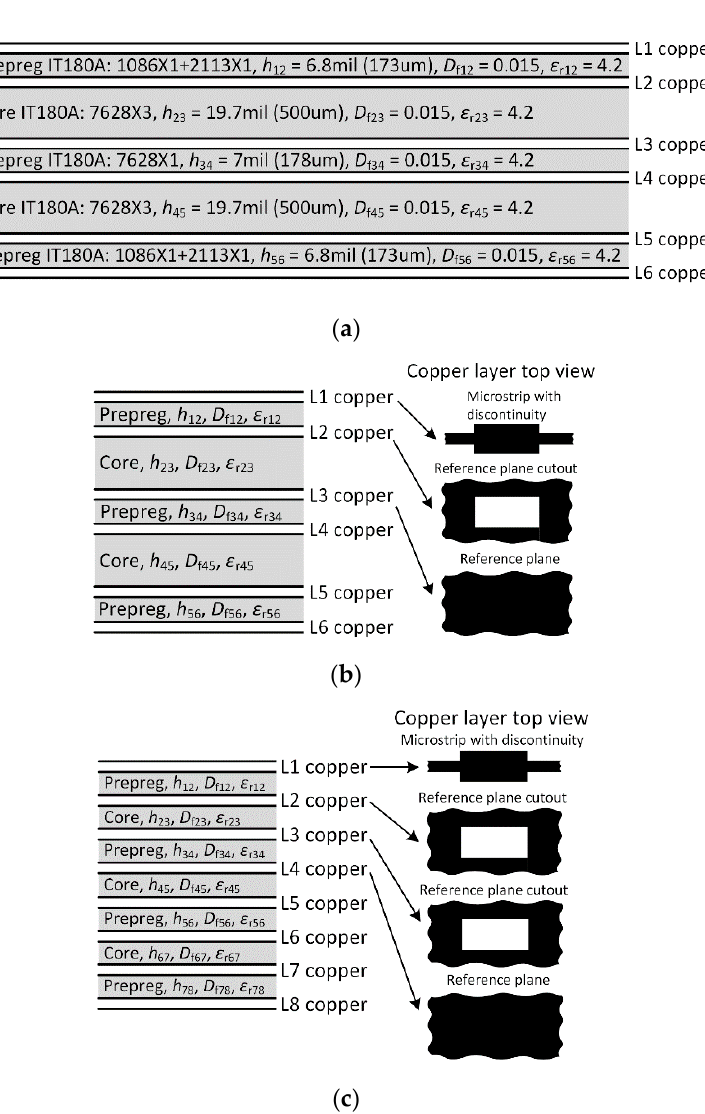
Figure 3. Printed circuit board (PCB) stackups: measured 6-layer board detailed stackup ( a ); general 6-layer ( b ) and 8-layer ( c ) board stackup with discontinuity compensation.